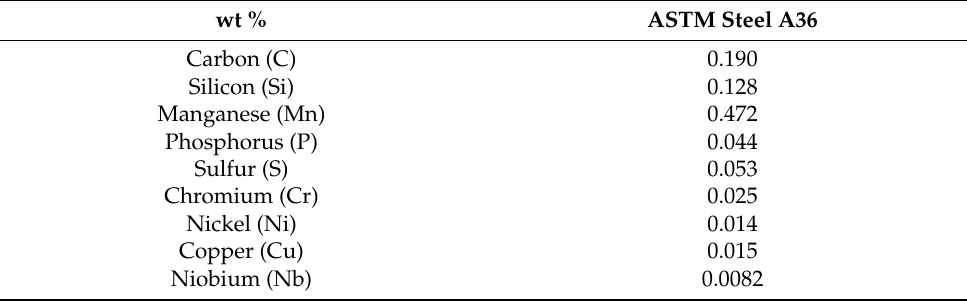
Table 1. Chemical composition (wt %) of ASTM